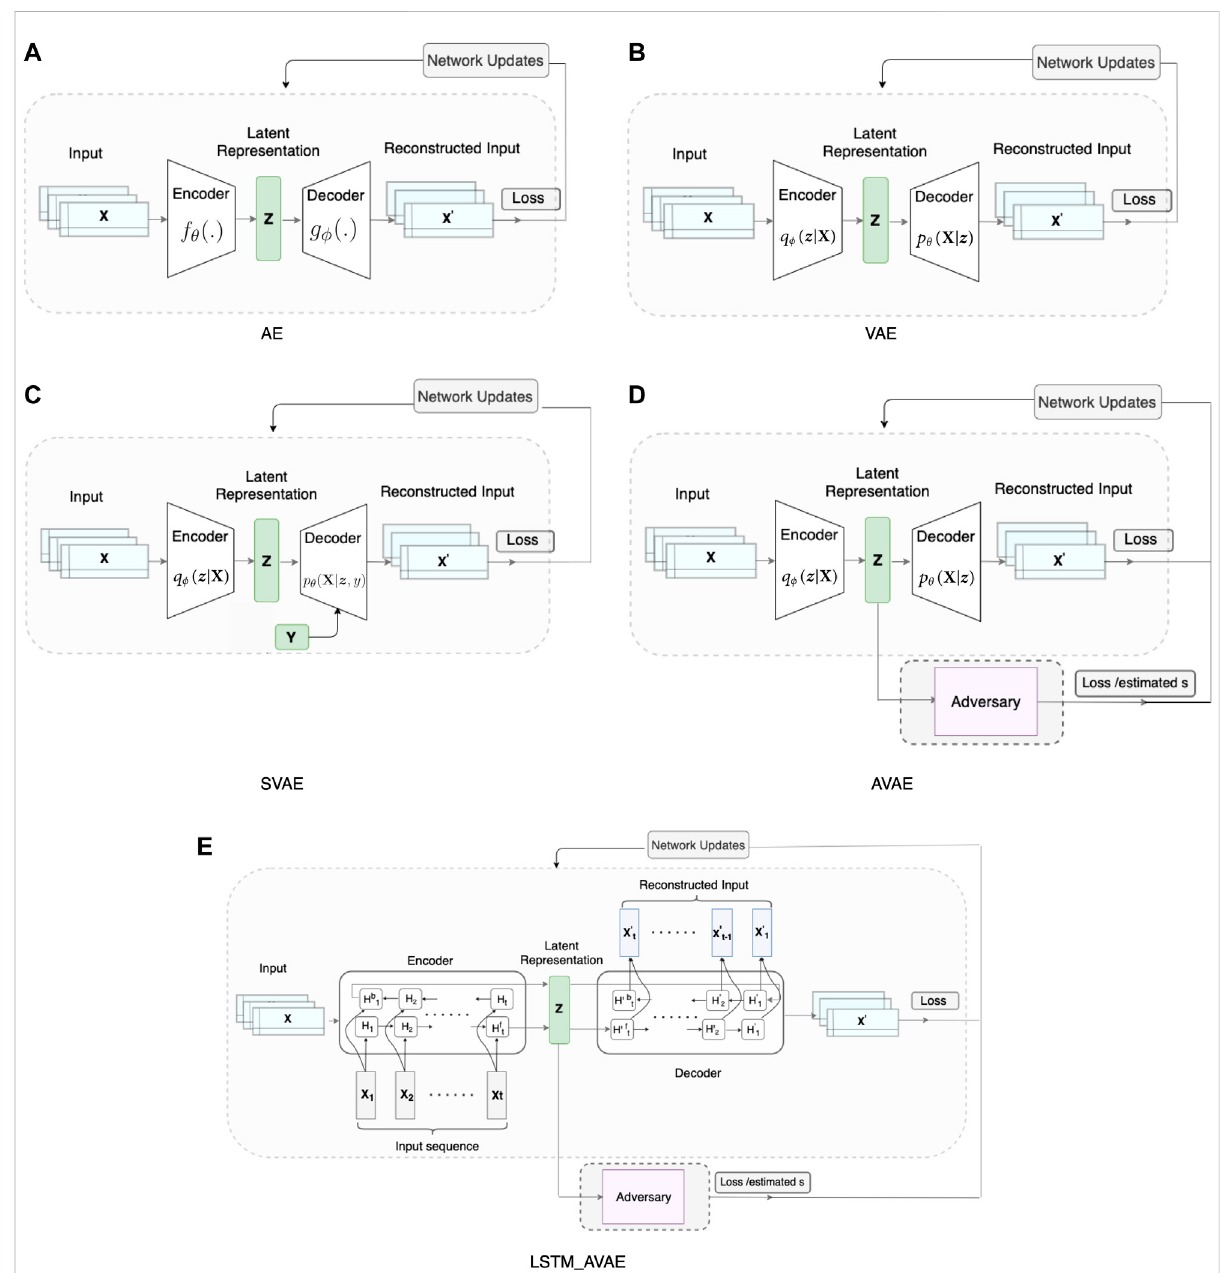
FIGURE 2 Autoencoder-based data representation learning models: (A) simple autoencoder (AE), (B) variational autoencoder (VAE), (C) supervised VAE (SVAE), (D) adversarial VAE (AVAE), (E) proposed LSTM-AVAE.